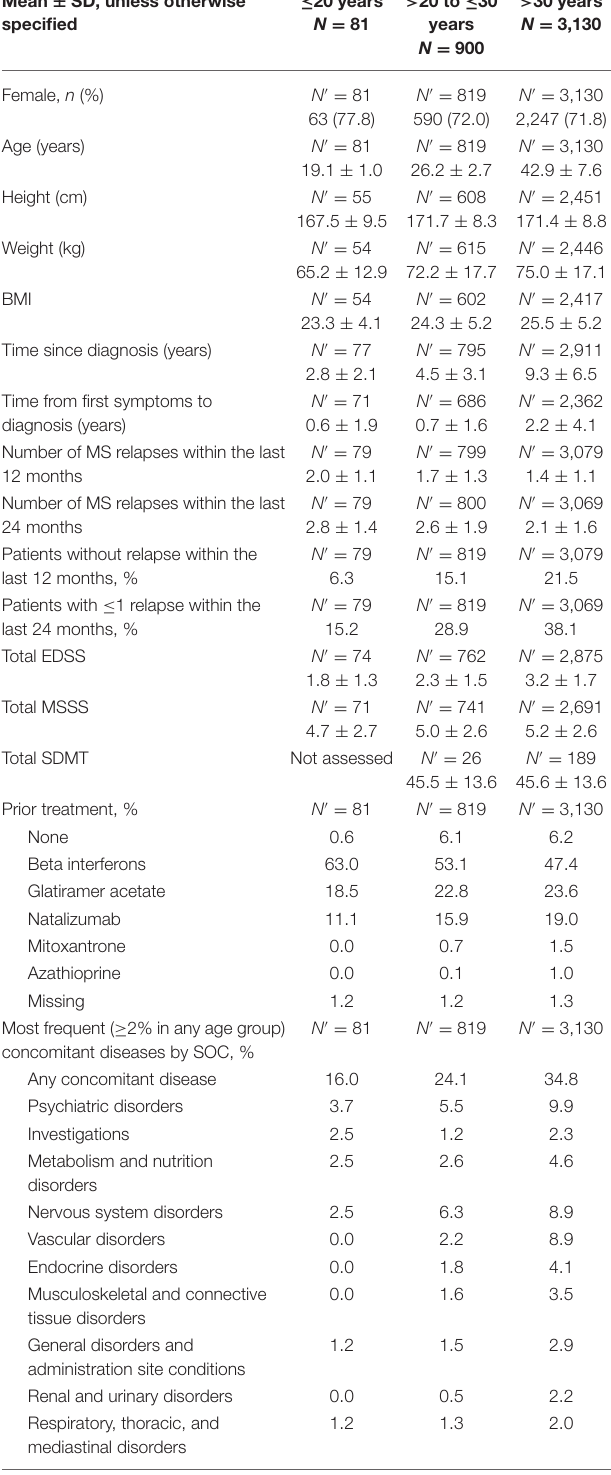
TABLE 1 | Patients’ characteristics, disease history, and pretreatment at